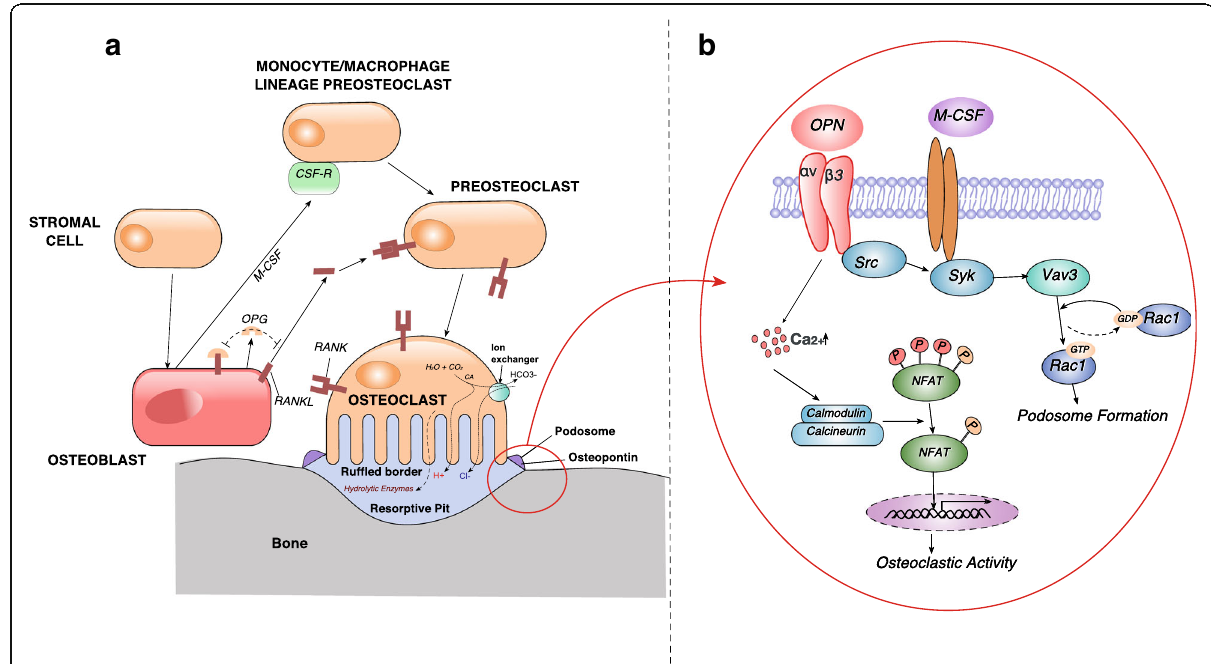
Fig. 2 A schematic representation of bone resorption occurring at cellular and molecular level. a RANKL/RANK/OPG pathway and osteopontin in podosome formation. b Osteopontin binding to integrin α v β 3 leads to podosome formation and osteoclastic activity via Rac and NFAT pathway respectively. M-CSF (macrophage colony-stimulating factor), CSF-R (colony-stimulating factor receptor), RANKL (receptor activator of nuclear kappa-B ligand), RANK (receptor activator of nuclear kappa-B), OPG (osteoprotegerin), Src (proto-oncogene tyrosine-protein kinase), Syk (Spleen tyrosine kinase), Vav3 (vav guanine nucleotide exchange factor 3), Rac1 (Ras-related C3 botulinum toxin substrate 1), NFAT (nuclear factor of activated T